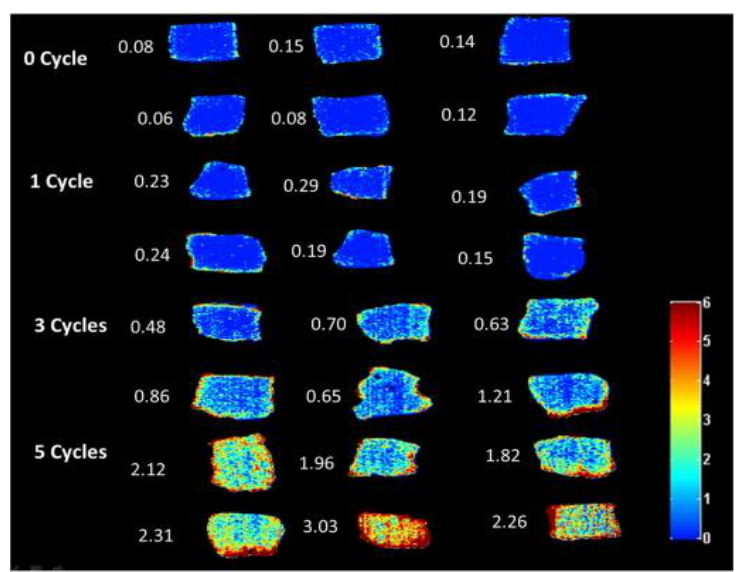
Figure 3. Chemical maps of TBARS distribution in pork samples by different frozen–thawed cycles [91].